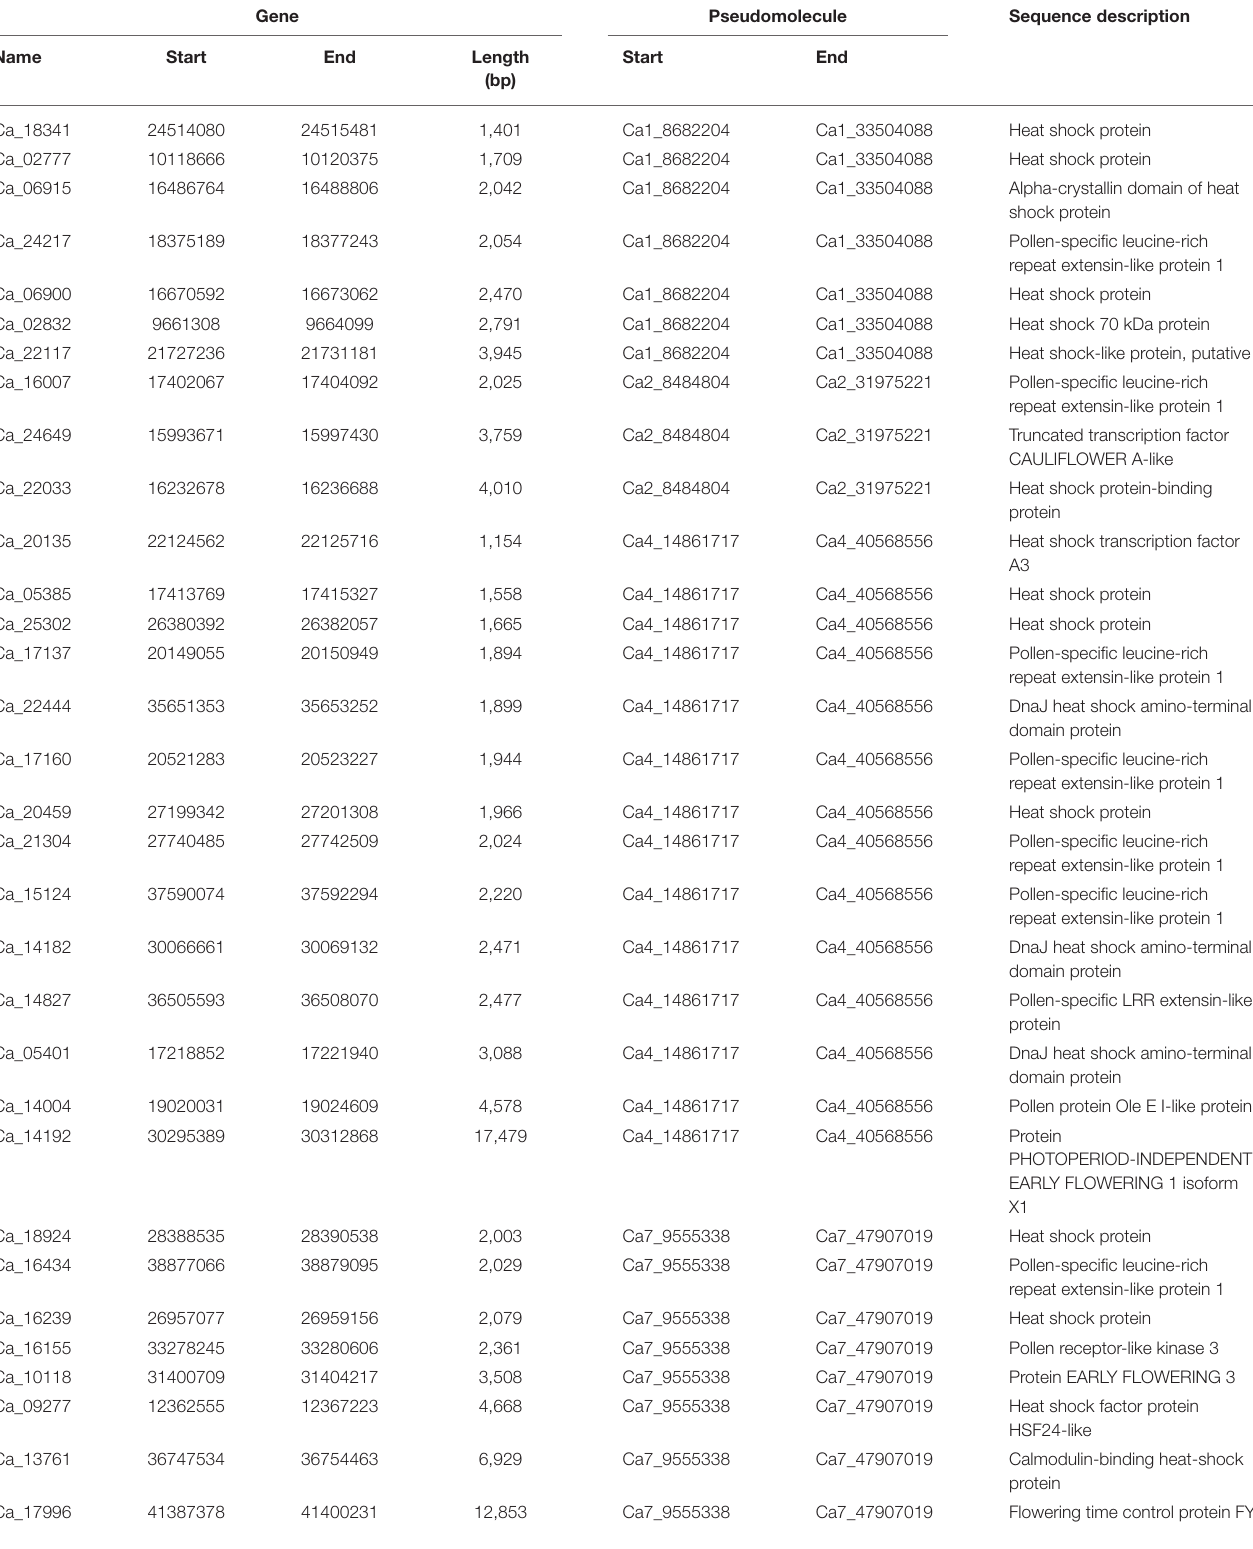
TABLE 3 | Key heat stress responsive genes in the QTL regions. Gene Pseudomolecule Sequence